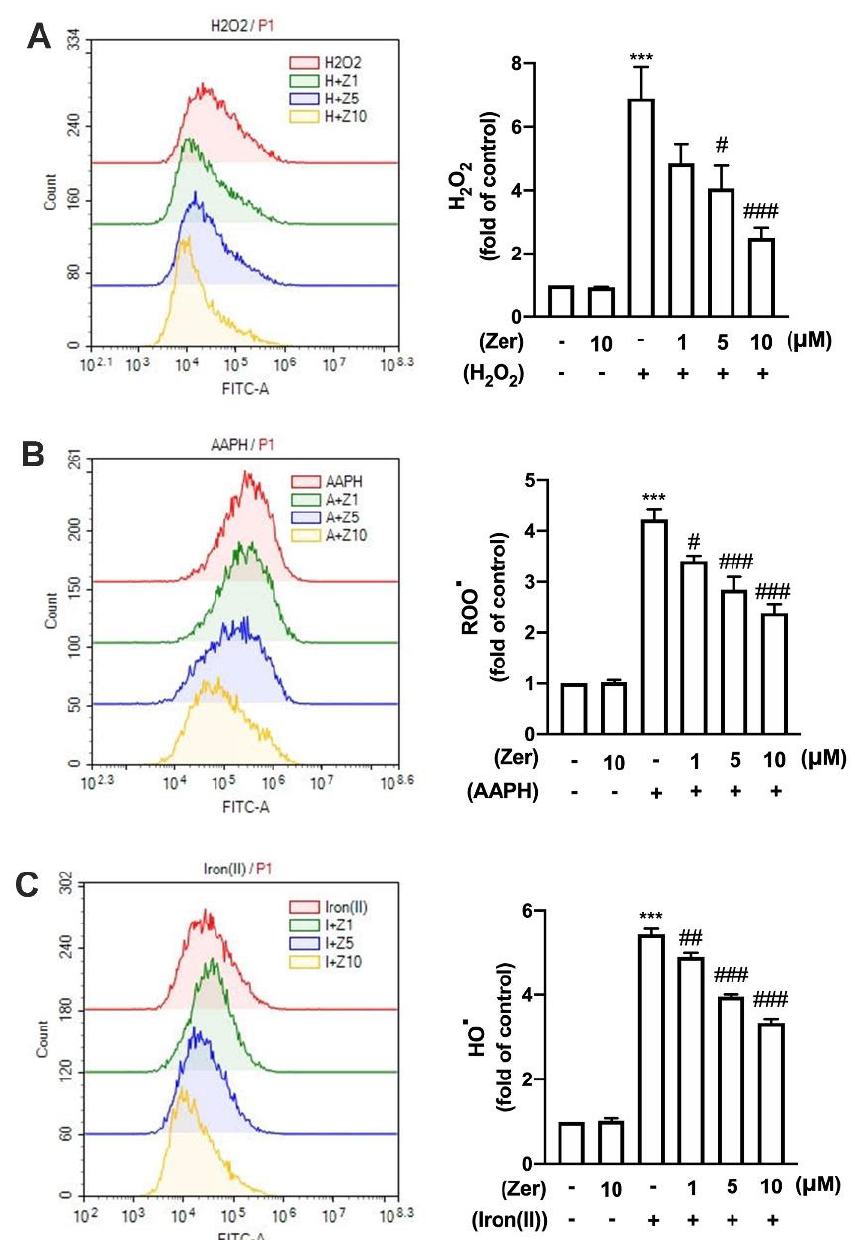
Figure 2. Effects of zerumbone on ROS production in microglia. IMG cells were supplemented with various concentrations of zerumbone (1, 5, or 10 µ M) for 30 min, followed by 5 mM H 2 O 2 ( A ), 5 mM AAPH ( B ), or 1 mM iron (ll) with 0.5 mM H 2 O 2 ( C ) for another 90 min. The intensity of dichlorofluorescein (DCF) fluorescence was detected through flow cytometry after 40 min of incubation with 10 µ M dichloro-dihydro-fluorescein diacetate (DCFH-DA). Quantitative data are represented as the mean ± SEM ( n = 4). *** p < 0.005 compared with the control group. # p < 0.05, ## p < 0.01, ### p < 0.005 compared with the treatment group alone.